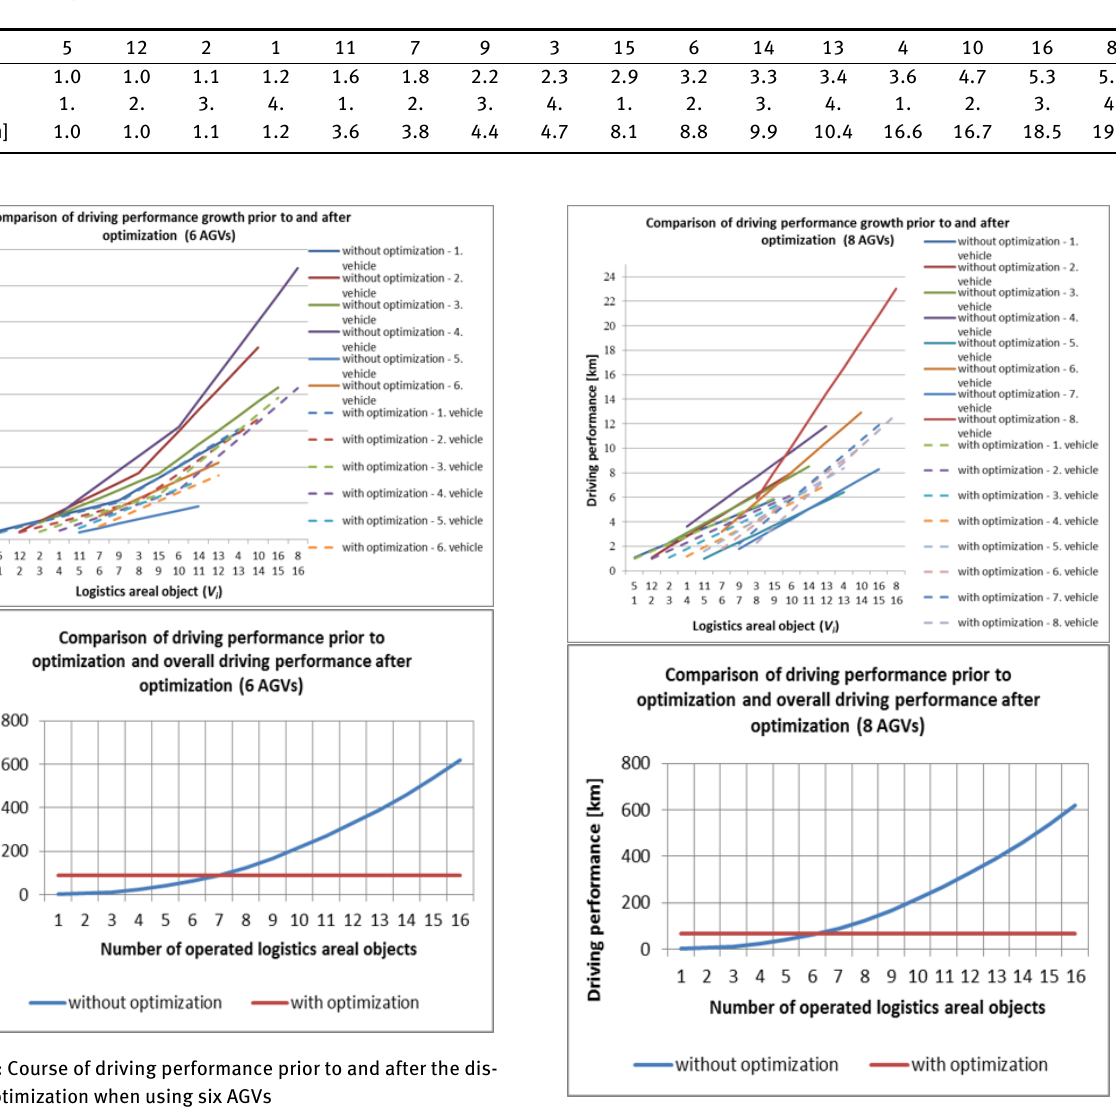
Figure 6: Graphical overview of driving performance prior to dp = 127.5 km i i =1